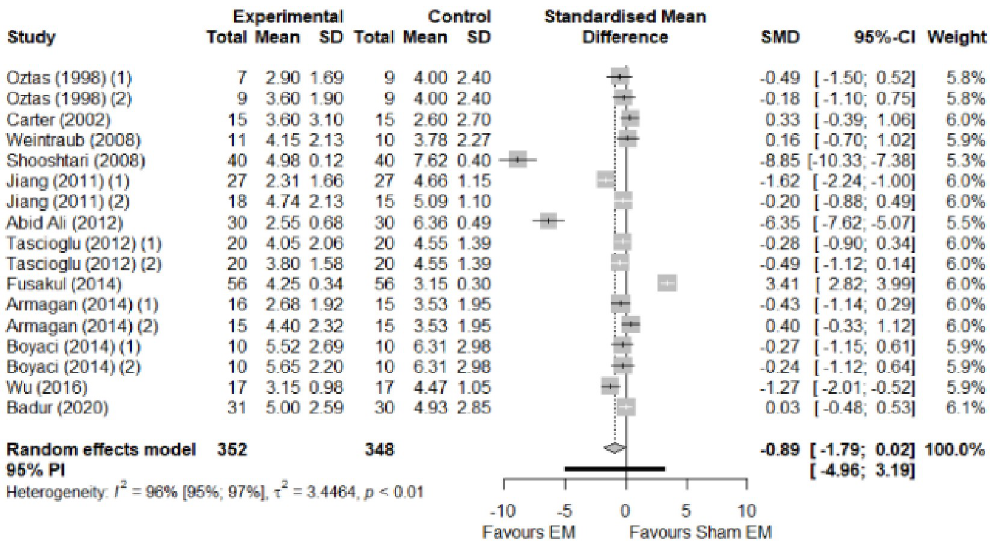
Fig 2. Analysis—Electrophysical modalities versus placebo (pain). Studies with more than two intervention groups (different modalities, treatment doses, or symptom classification) were numbered as (1) and (2).